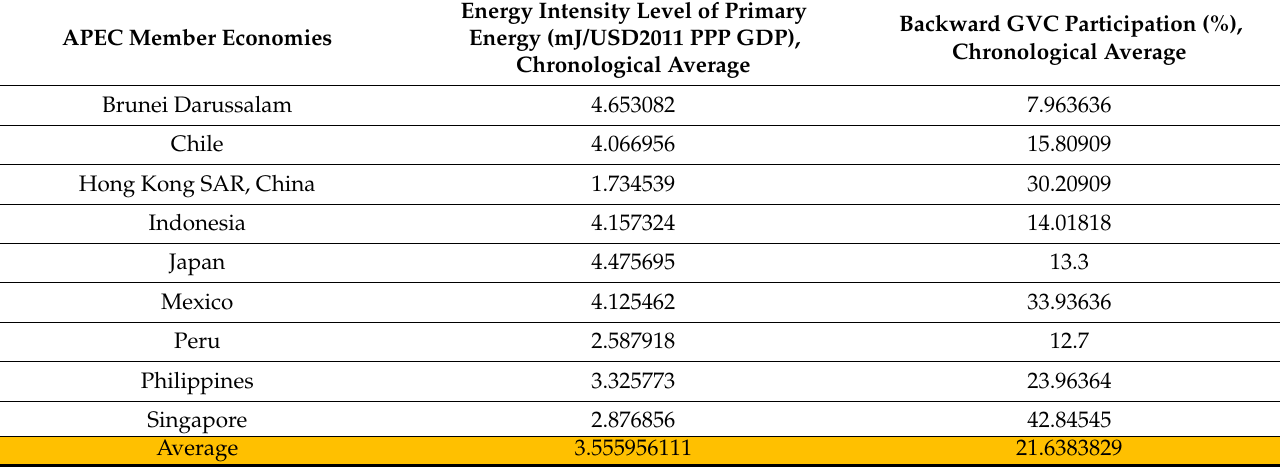
Table 17. APEC member economies with lower energy intensity level of primary